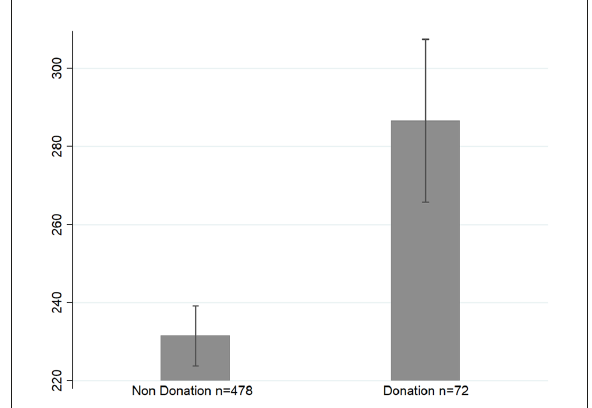
FIGURE3 The time participants spent watching videos varied substantially (bars are SDs). The line shows the proportion of people who watched the entire video.